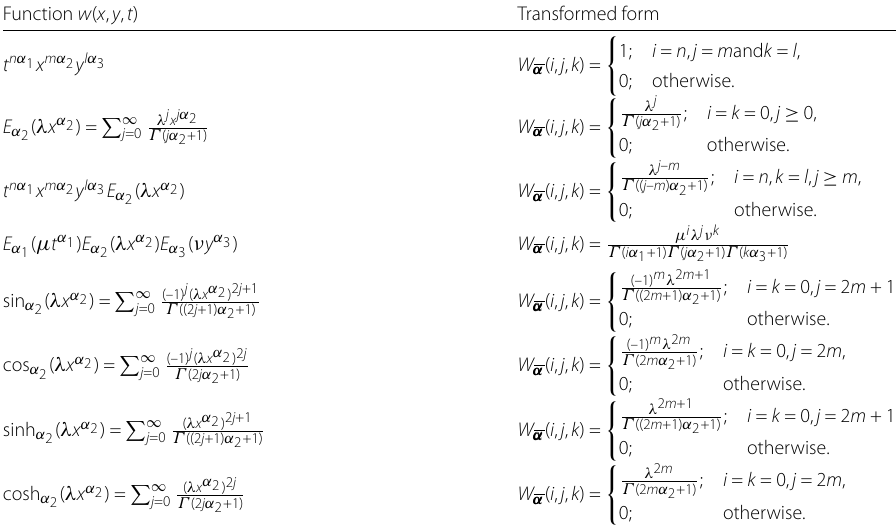
Table 1 Ternary-FDT for some basic functions Function w ( x , y , t ) Transformed